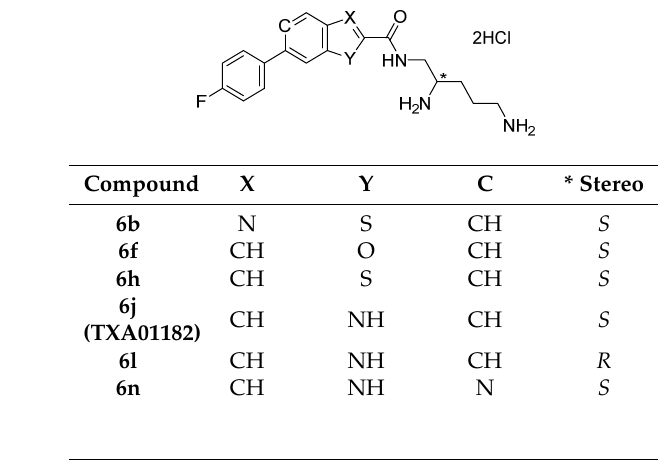
Table 2. Screening results of levofloxacin potentiation by fused heterocyclic carboxamides (6.25 µg/mL) in P. aeruginosa ATCC 27853 *.